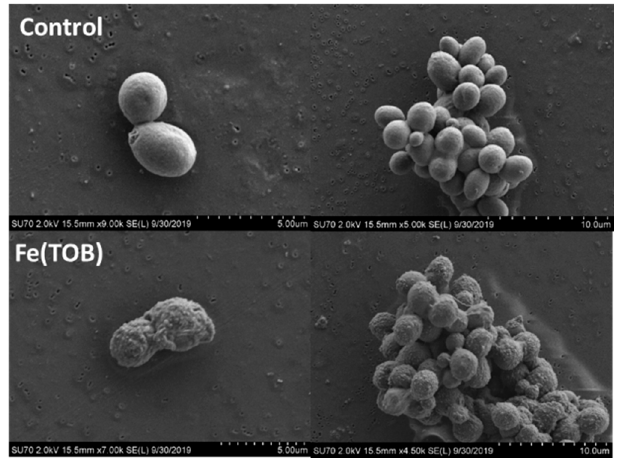
Figure 4. Scanning electron micrograph of the control and Fe(TOB)-labeled S. cerevisiae